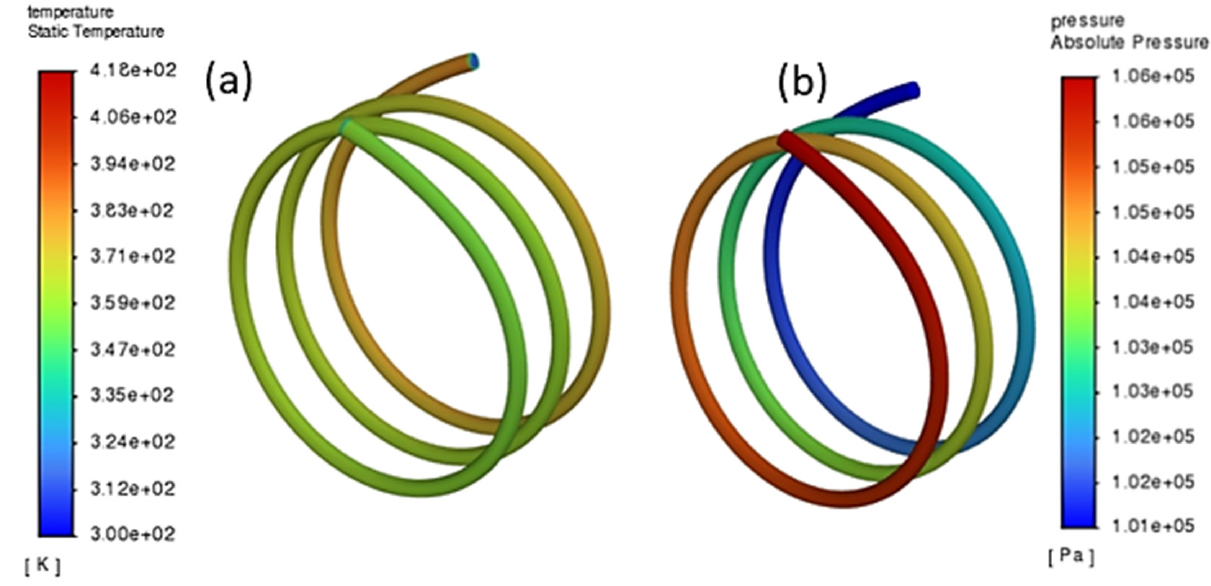
Figure 9. ( a ) Helical geometry temperature distribution. ( b ) Helical geometry pressure distribution. Table 1. Mass flow rate from Helical water jacket.